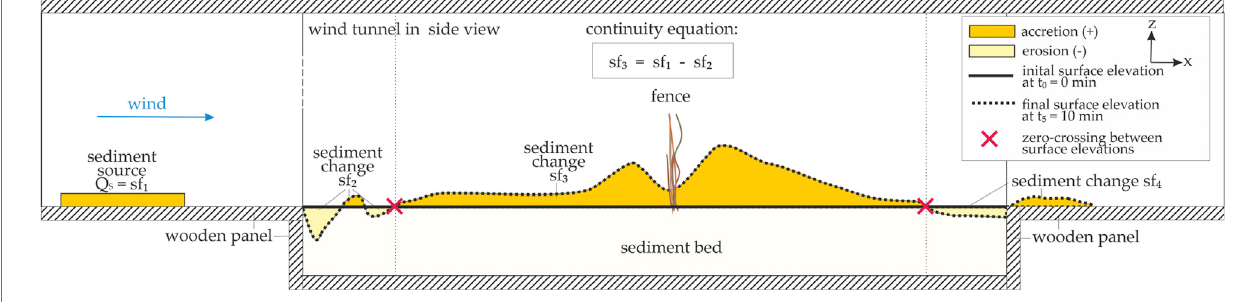
Frontiers in Built Environment |